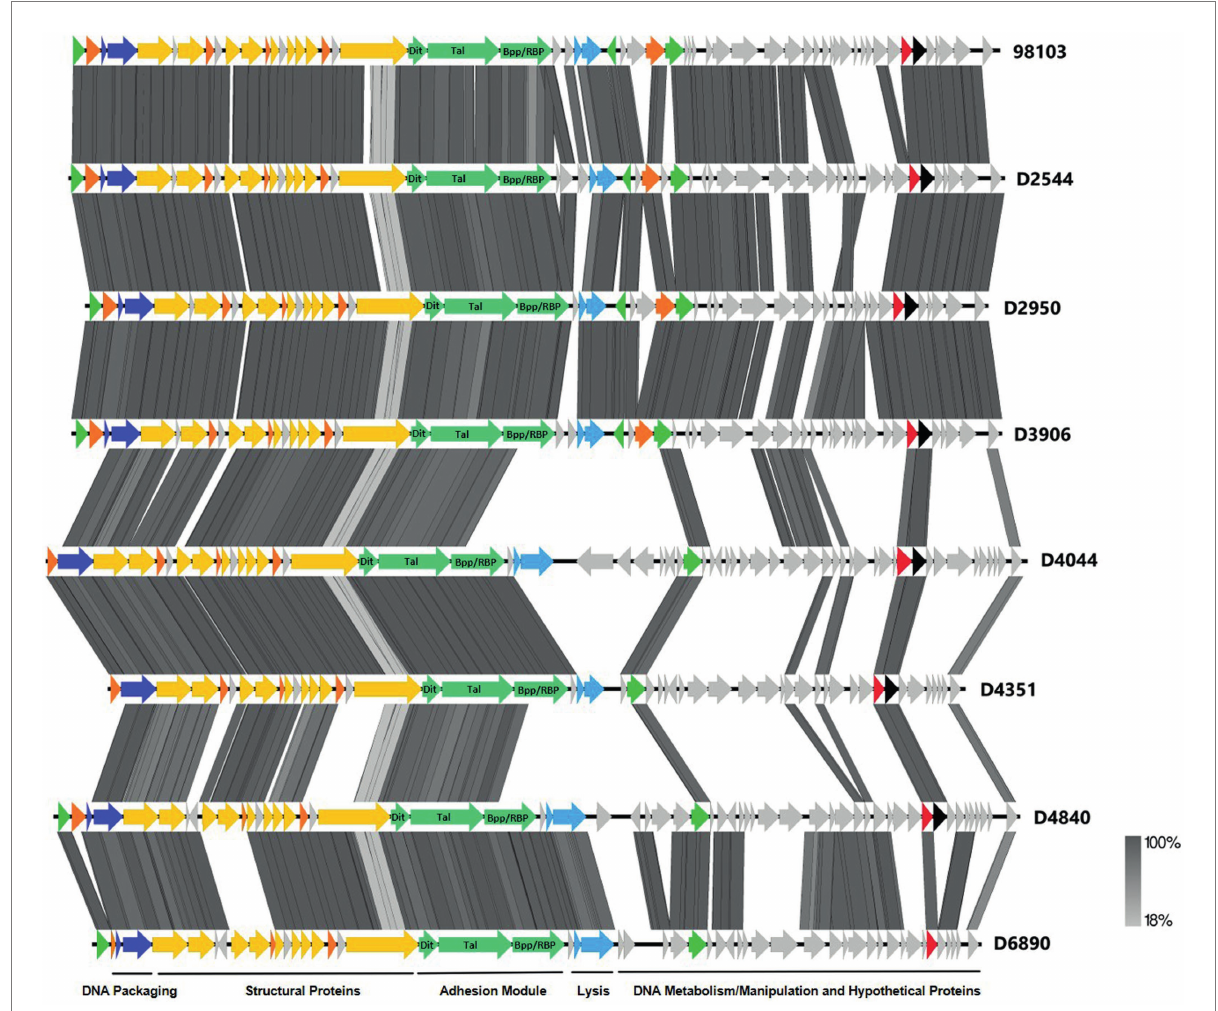
FIGURE 3 Whole-genome alignment of P335 phages highlighting the localization of the adhesion module. IFF P335 phage genomes described in this study along with phage 98103 were globally aligned. Regions of similarity exhibiting a minimum identity overlap of 100 bp are shown in varying scales of gray according to the percentage identity observed. Genes exhibiting globally related functions possess the same color scheme and are identified according to the modular descriptions provided at the bottom of the